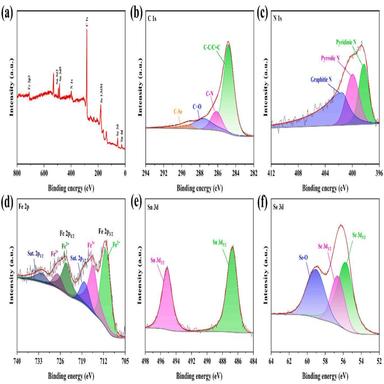
XPS survey spectrum (a) and high-resolution spectrum of (b) C1s, (c) N1s, (d) Fe 2p, (e) Sn 3d and (f) Se 3d of FeSnSe/SCNFs-1.